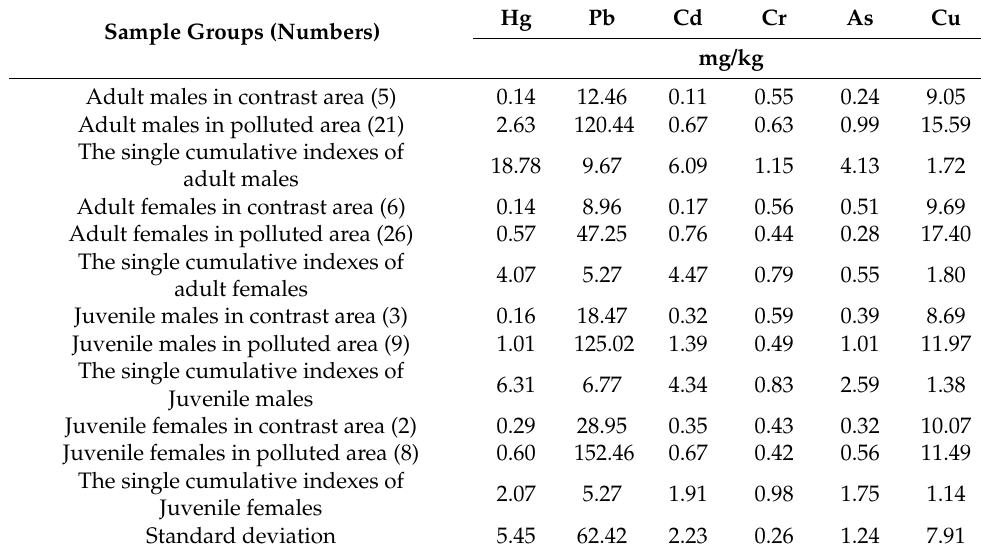
Table 3. The single cumulative index of toxic trace elements in human